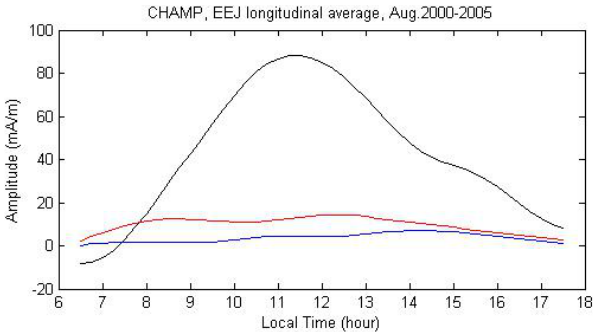
Fig. 3. Phase propagation of the semi-monthly lunar tide as a function of moon phase. Dots mark for each local time hour the moon phase when the tidal wave crest is observed.